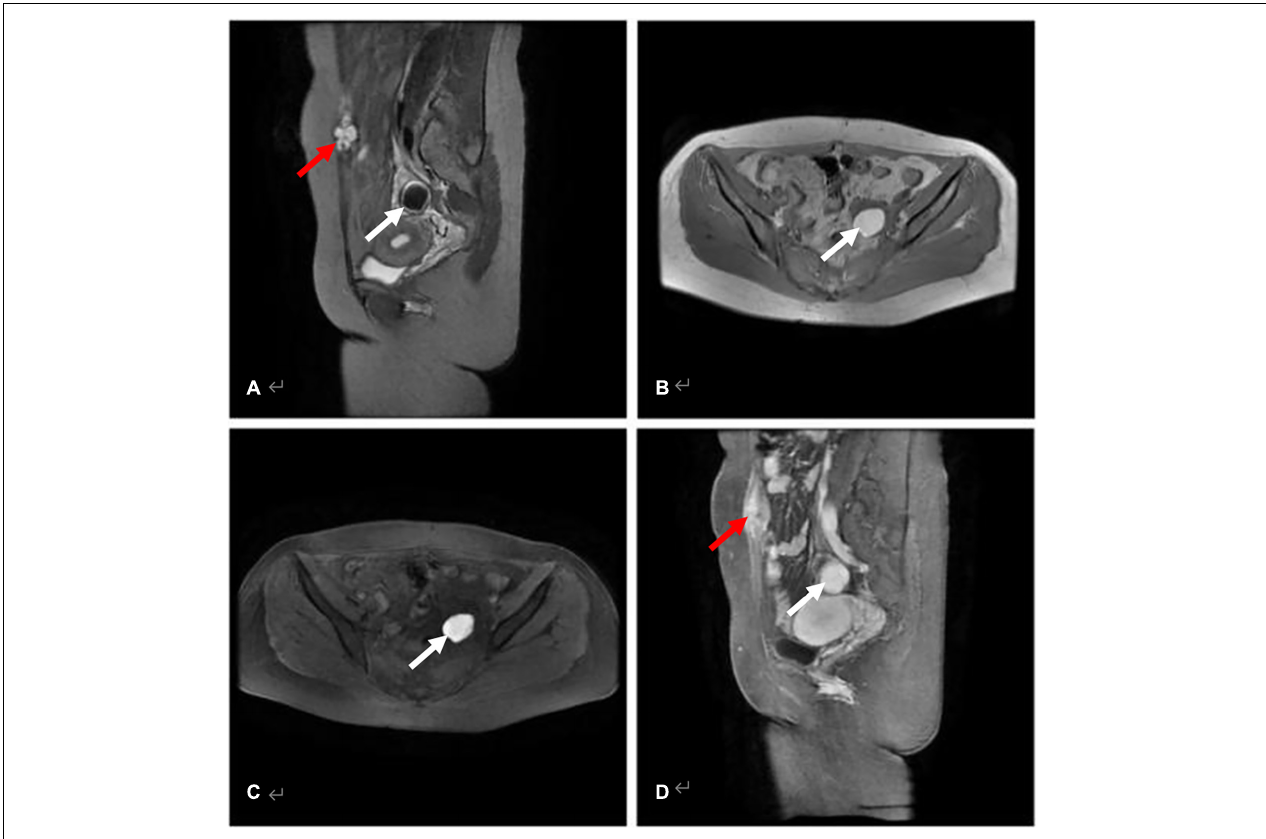
FIGURE 3 | AWE in a 29-year-old woman with a history of transabdominal left ovarian endometriosis cyst excision and cesarean section (median incision). (A) Sagittal T2WI with fat-suppression AWE lesion with high signal (red arrow), and cyst of ovarian endometriosis in the attachment area appeared hypointense when compared with muscle (white arrow). (B,C) Axial T1WI without and with fat-suppression revealed an endometriosis cyst in the left attachment area with the cyst showing a higher signal than that of muscle (white arrow). (D) The AWE lesion (red arrow) and the endometriosis cyst (white arrow) shows evident enhancement on post-contrast T1WI.